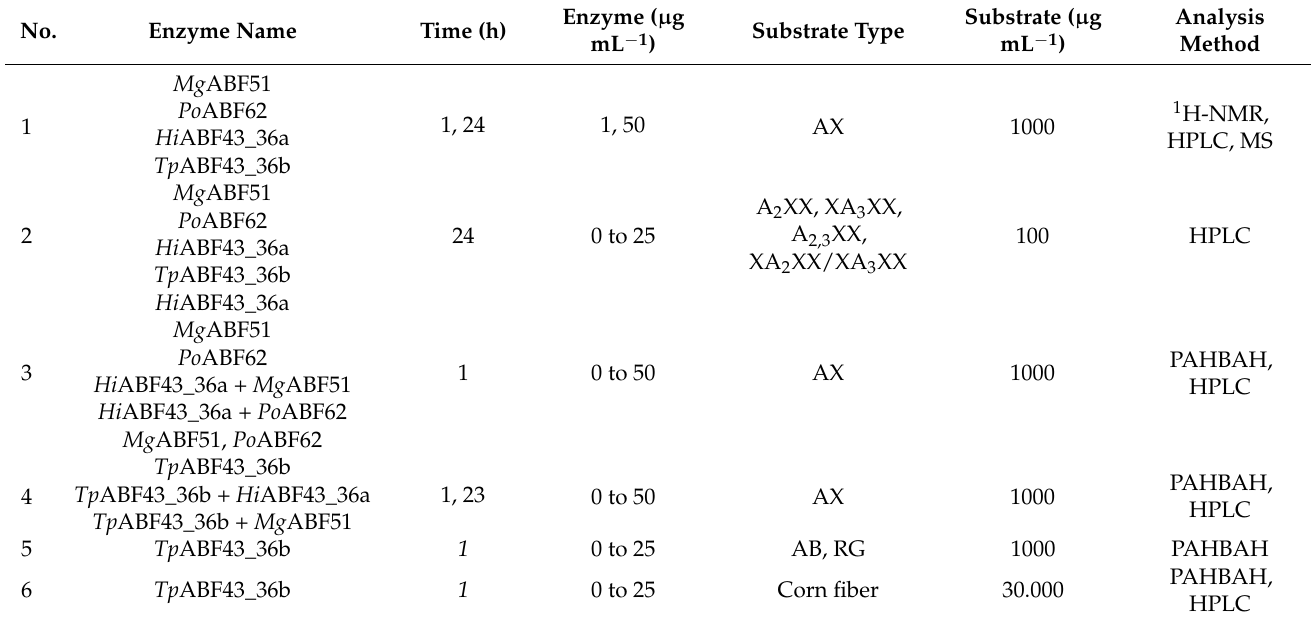
Table 3. Enzyme incubations with experiment number performed with corresponding